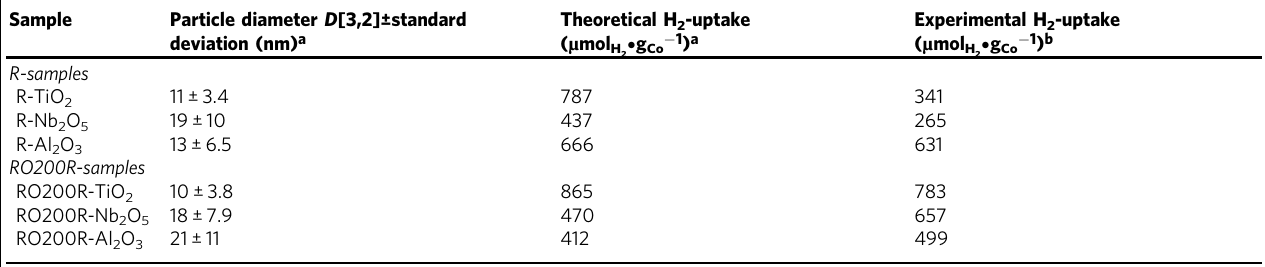
Table 1 The results of cobalt particle size analyses using STEM-EDX and H 2 -chemisorption for the pristine samples after reduction at 350 °C (R-samples) and the samples after reduction at 350 °C, oxidation at 200 °C, and reduction at 220 °C